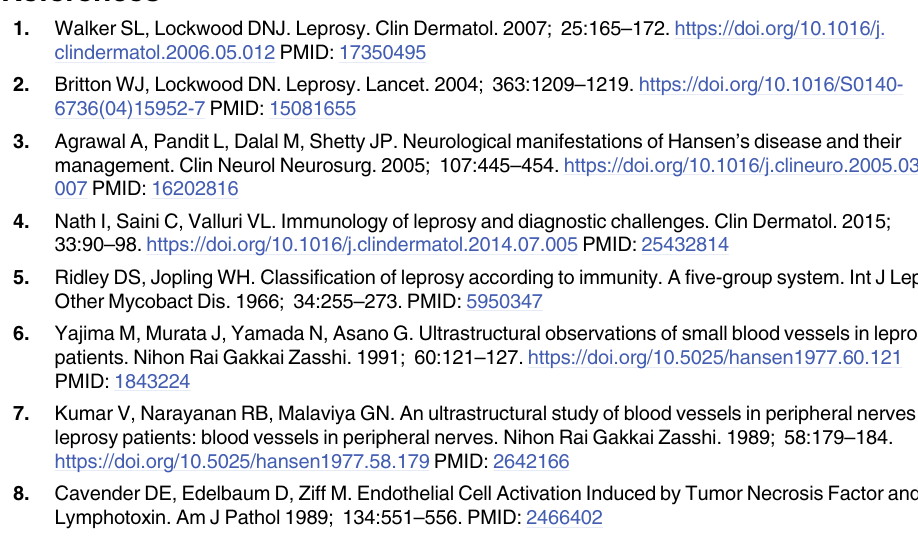
S1 Table. Spectral analysis of flowmotion. S2 Table. Acetylcholine and sodium nitroprusside iontophoresis. S3 Table. Sidestream dark field